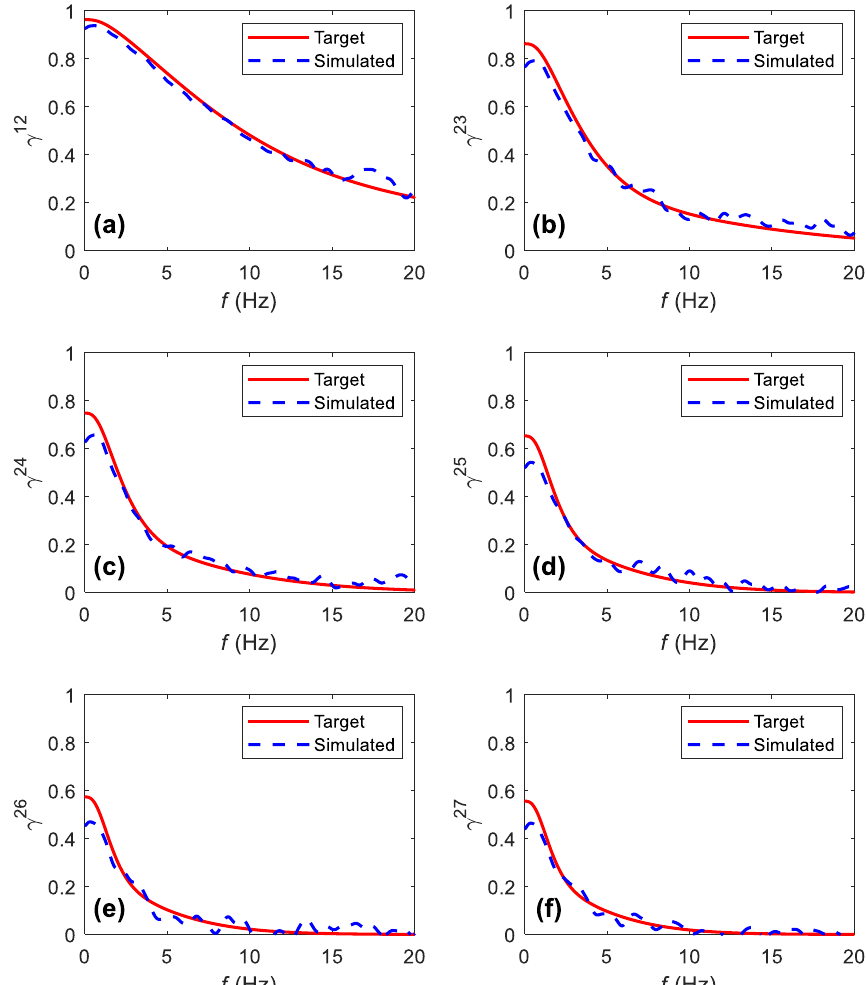
Fig. 7 Comparison between the estimated and target coherences in the numerical example: a coherence γ 12 with d 50 m, b coherence γ 23 with d = d 600 m, e coherence γ 26 with d =